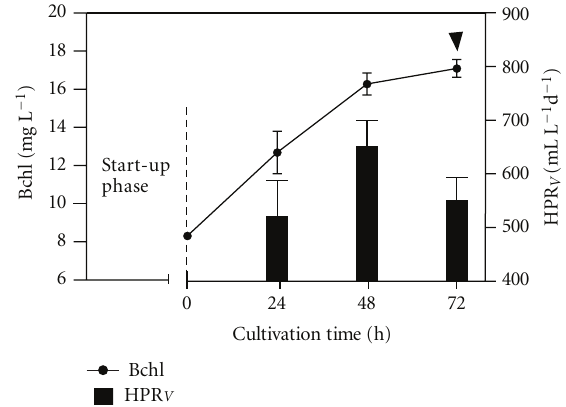
Figure 6: Changes in the Bchl concentration versus the cultivation time and relative HPR V achieved in time, under SCR, at 30 ◦ C with an irradiance of 480 Wm − 2 . The HRT was 138 hours. The arrow indicates the cultivation time when we withdrew 120mL of culture volume from the reactor and replaced with an equal volume of fresh